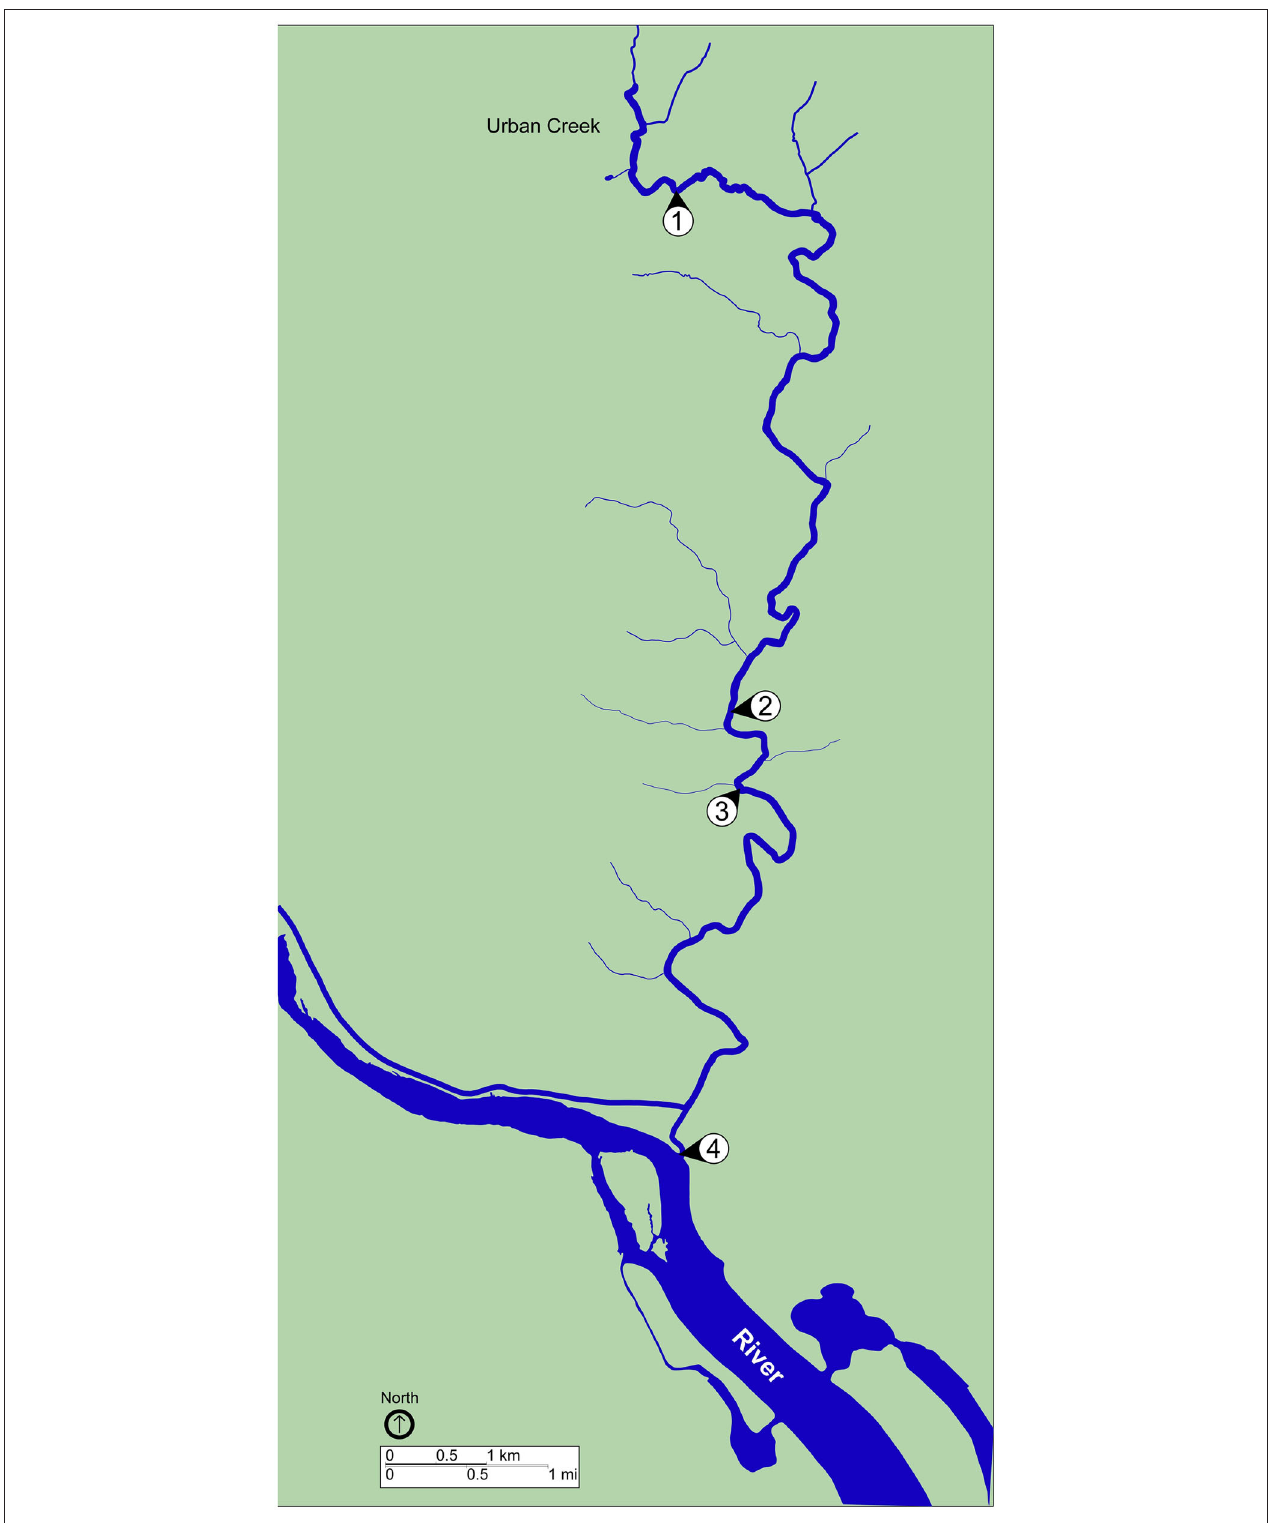
FIGURE 1 | Map of sampling locations. Map shows sites of surface water collection during dry weather, September 23, 2019, and post rainfall, October 24, 2019. Water samples were collected at all four sites during each sampling event. Blue, waterway; green, land. Scale bars are shown to indicate distance.